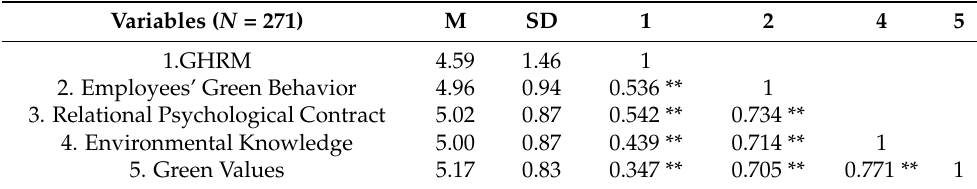
Table 2. Descriptive statistical analysis